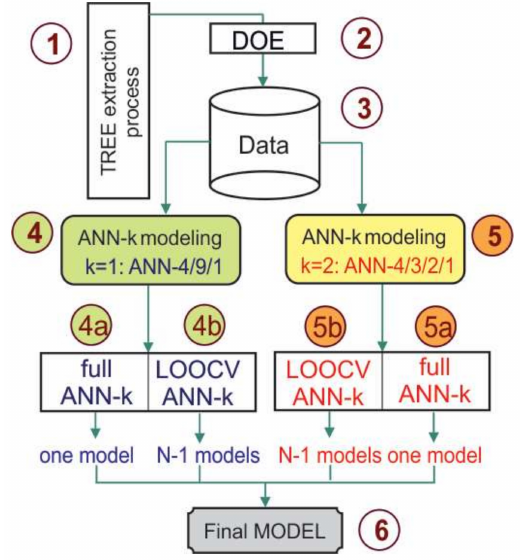
Figure 9. ANN TREE extraction